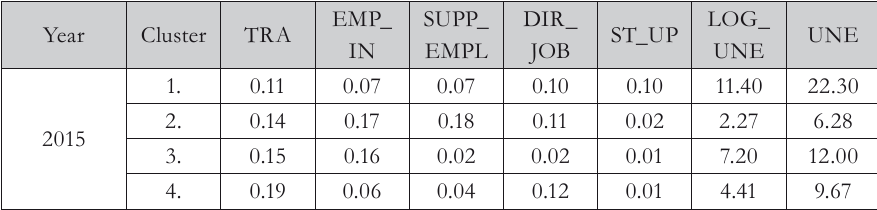
Fig. 7 – The dendrogram based on the selected variables in 2015. Source: Own estimation. Tab. 3 – Average values of variables from cluster 2015. Source: Own